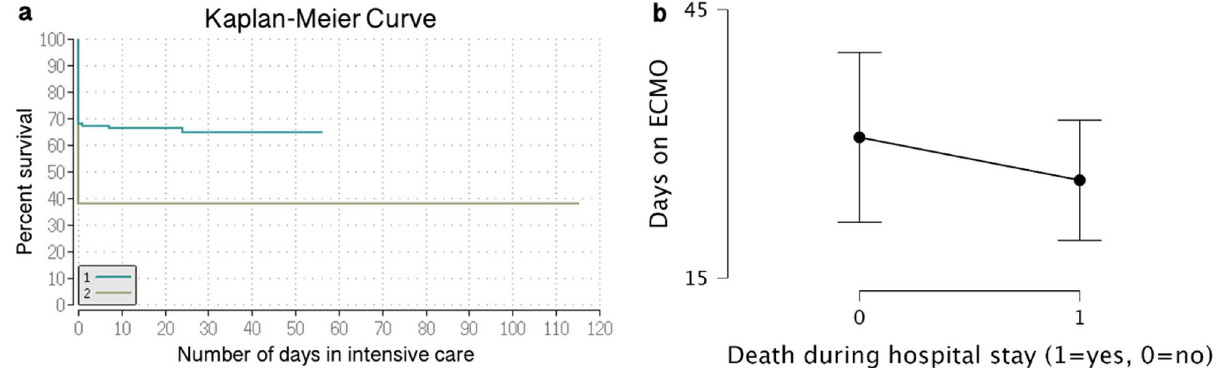
Figure 2. Covid-19 patient survival with and without VV-ECMO intervention during their hospital stay. ( a ) The Kaplan–Meier estimator was used to estimate survival function. The starting-point was ICU admission and the endpoint was ICU discharge. Group 1 = critically ill COVID-19 patients treated without VV-ECMO; Group 2 = critically ill COVID-19 patients with VV-ECMO treatment. Critically ill COVID-19 patients with VV-ECMO treatment had a significantly lower survival during the hospital stay compared to those without the treatment (p < 0.001). ( b ) Among the VV-ECMO patients there was no significant difference with regard to the number of days on VV-ECMO between the patients who died during their hospital stay and survivors (p = 0.35). The descriptive plot of means and error bars indicate the traditional 95% confidence